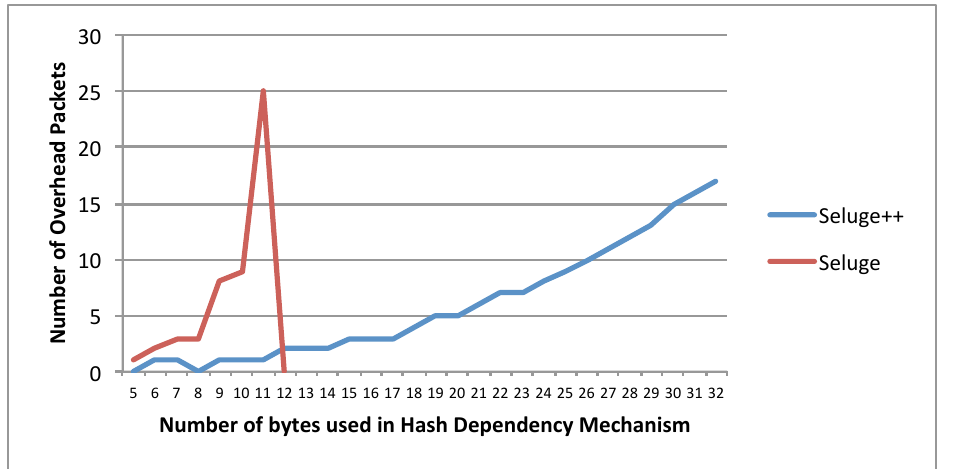
Figure 9. Overhead packets using different hash block lengths (from 40-bit to